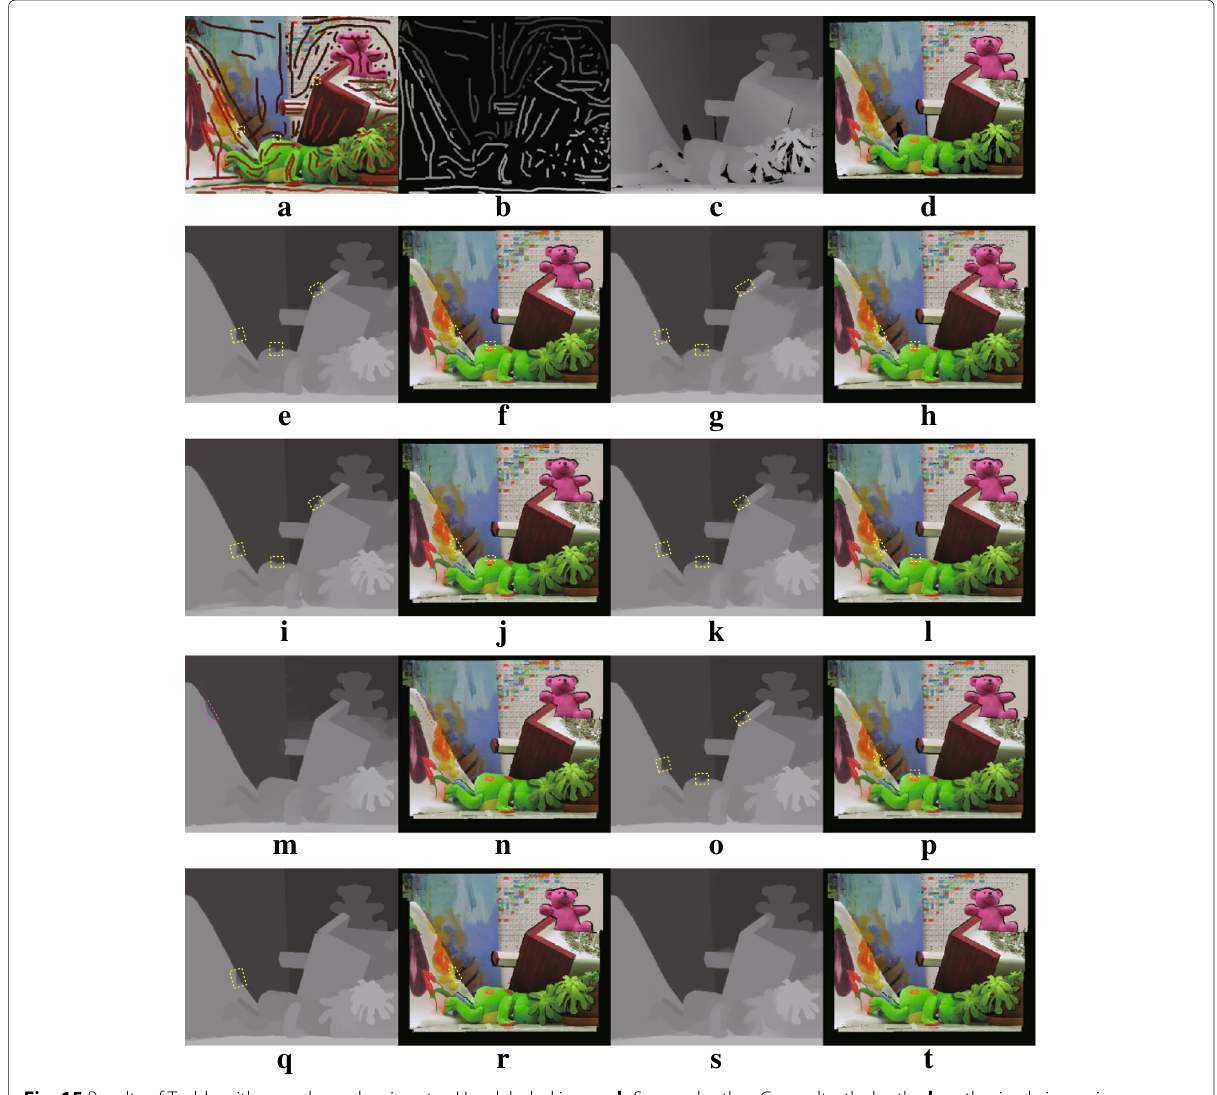
Fig. 15 Results of Teddy with cross-boundary input. a User labeled image. b Sparse depth. c Groundtruth depth. d synthesized view using c . e Depth of RW. f Synthesized view using e. g Depth of HGR. h Synthesized view using g . i Depth of NRW. j Synthesized view using i . k Depth of OPT. l Synthesized view using k . m Depth of OCP. n Synthesized view using m . o Depth of SDF. p Synthesized view using o . q Depth of (cid:2) 1 . r Synthesized view using q . s Depth of the proposed method. t Synthesized view using s . Please zoom in to see